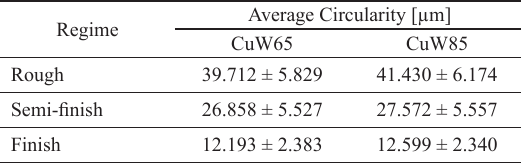
Table 3. WC-Co workpiece circularity deviations for rough, semifinish and finish ED-Machining using CuW65% and CuW85%